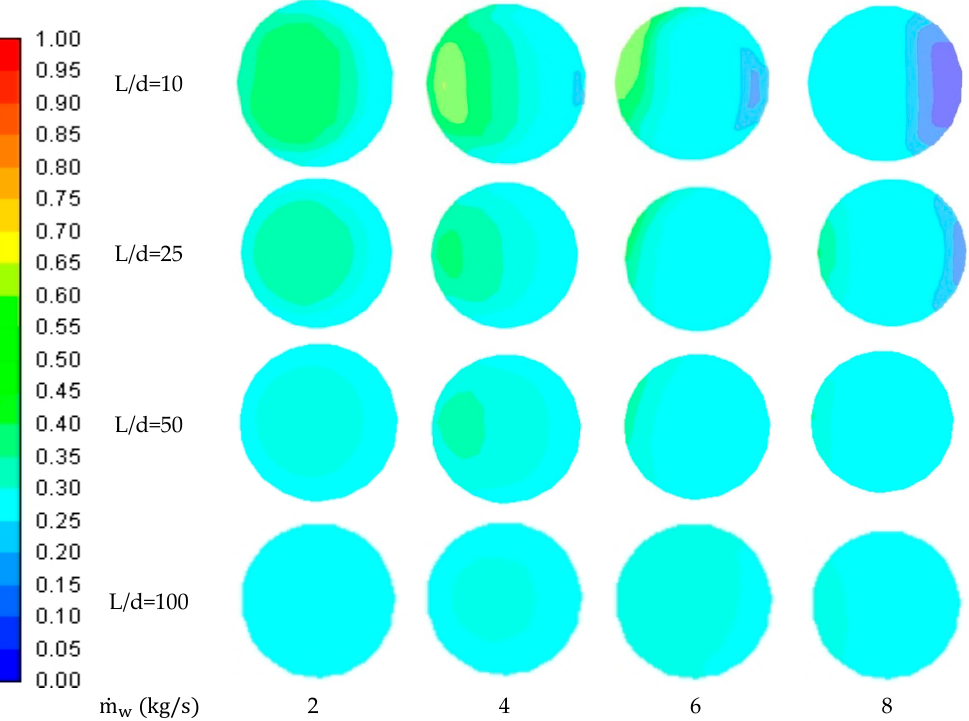
Figure 27. Radial air volume fraction contours at different downward distances from the side pipe centerline at various flow ratios and X w = 662.96, α m = 0.7 and X v = 0.5.